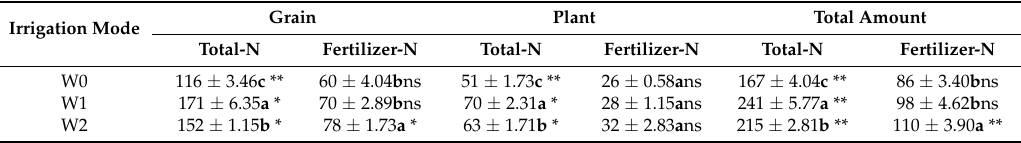
Table 2. Nitrogen uptake by rice grain and plant under at maturation stage kg/hm 2 ( a , b and c in the figure represented differences between groups for significance